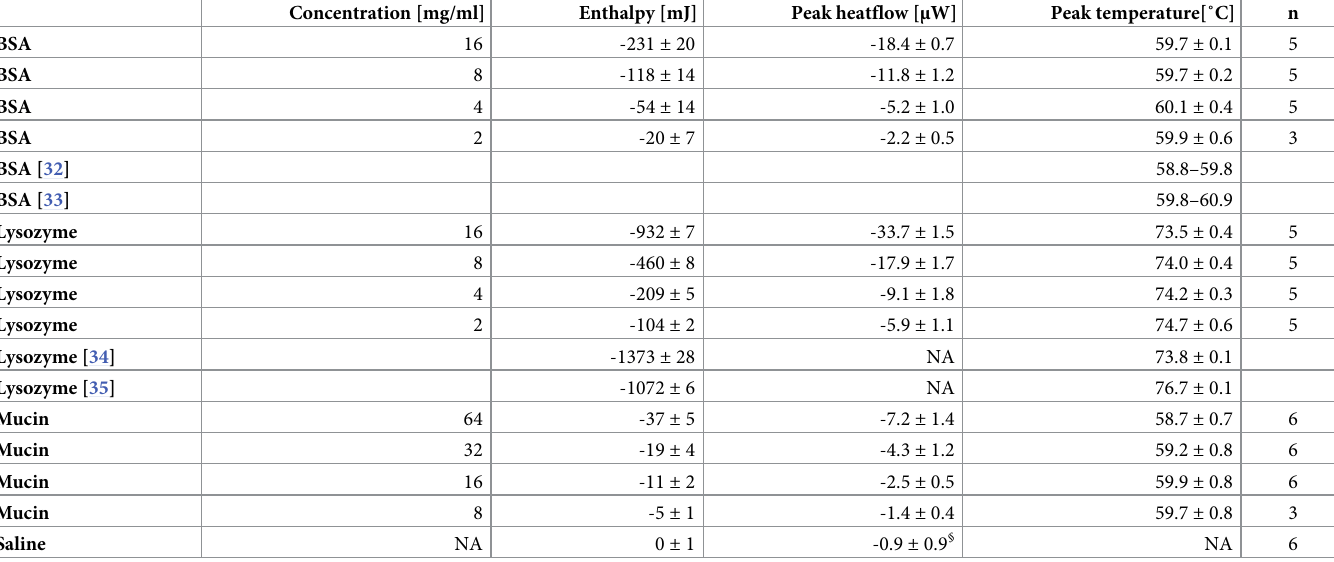
Table 2. Data showing the main DSC peak parameters (enthalpy, peak heatflow and peak temperature) for the standard protein